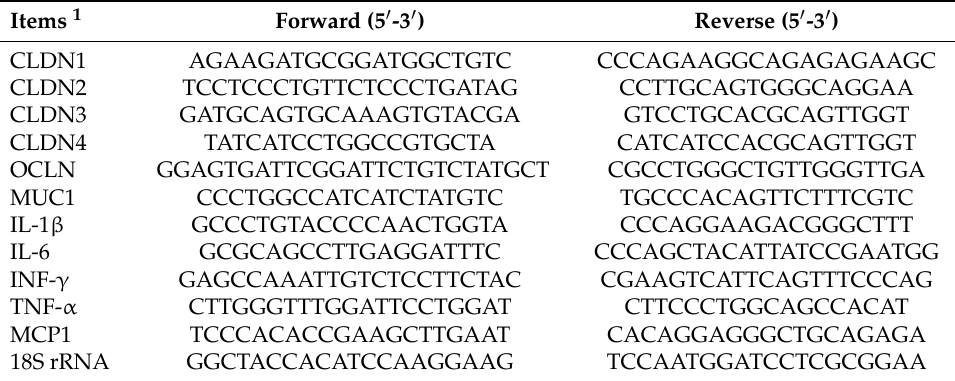
Table 2. Gene-specific primer sequences of tight junction protein and inflammatory cytokine genes in the ileal